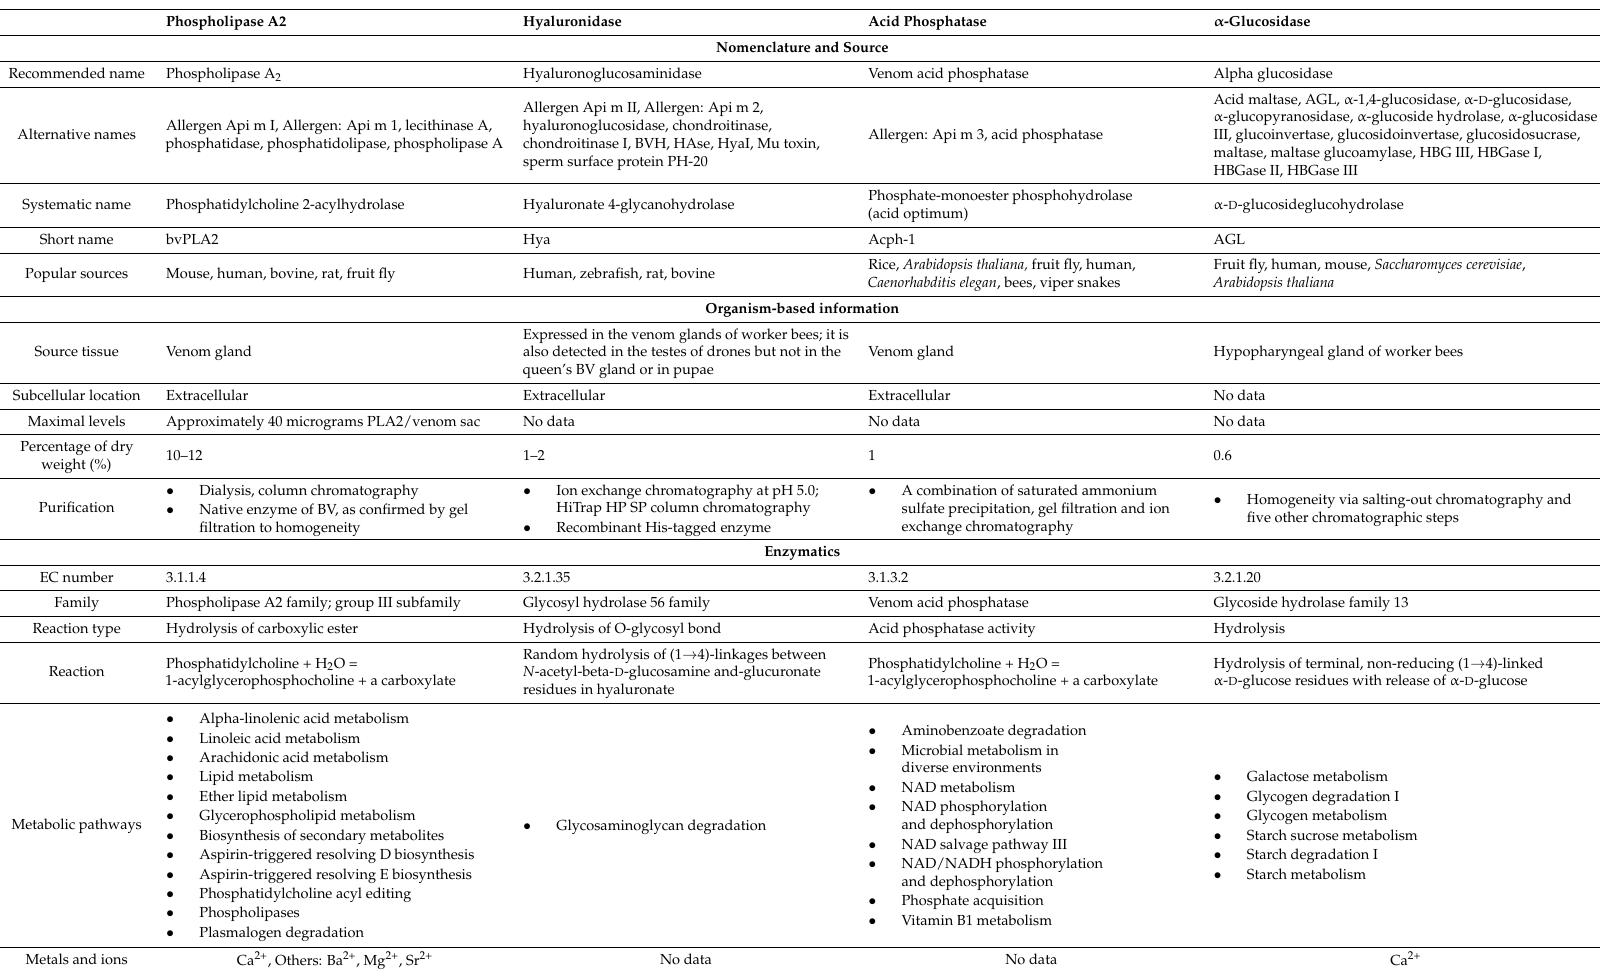
Table 2. Investigated information regarding Apis mellifera BV